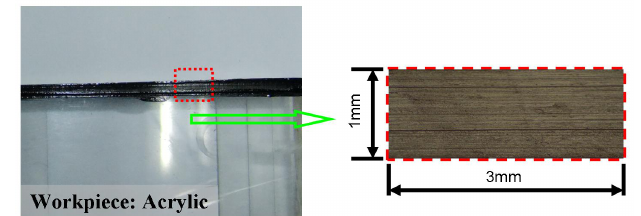
Figure 20. Micrograph of finished workpiece (acrylic).